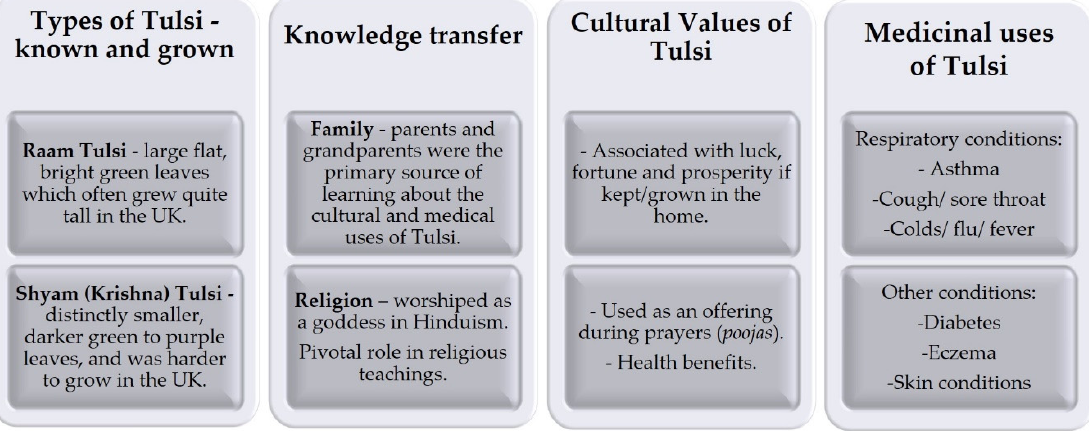
Figure 3. Key themes identified from thematic analysis of interviews with participants in the UK.